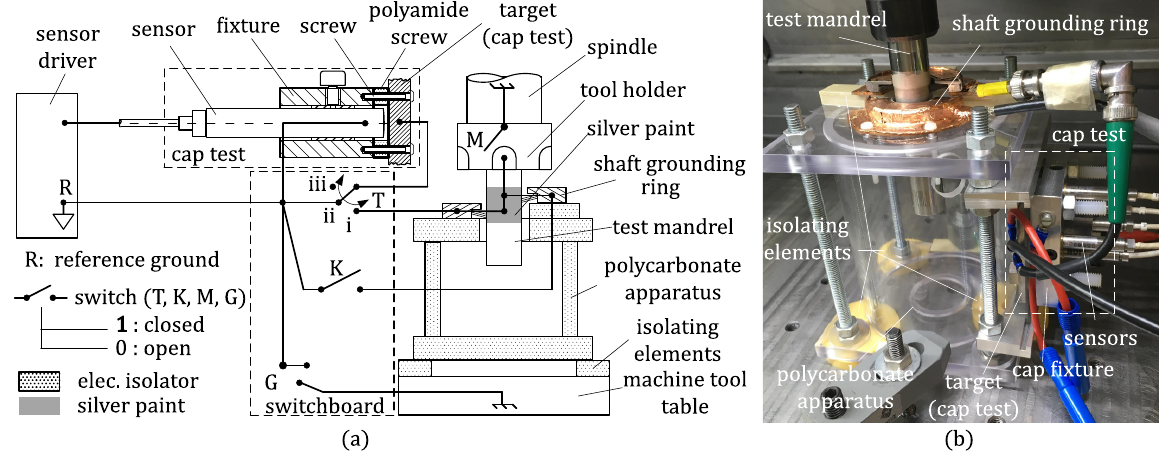
Figure 7. EMI testing device: ( a ) schematic; and ( b ) experimental setup on machine